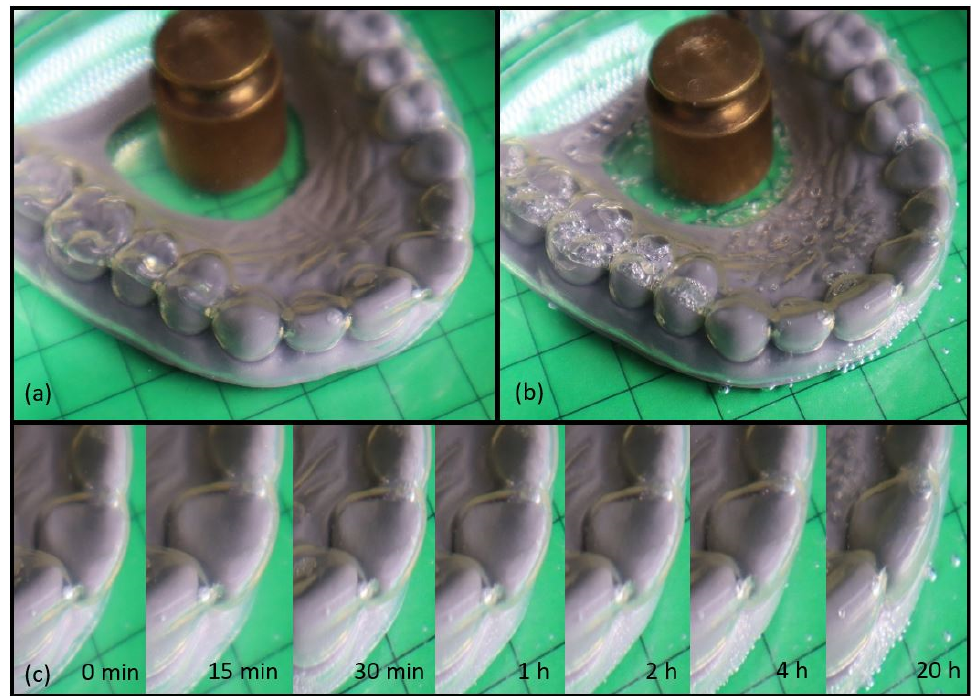
Figure 10. Water-responsiveness of a programmed TPU aligner with a misaligned incisor in 37 °C water (the weight prevented buoyancy). ( a ) A programmed aligner (0 min in a water bath), ( b ) a recovered aligner after storage for 20 h in a water bath, ( c ) a time-lapse activation of the shape memory effect depicted by the enlarged section of the incisor.